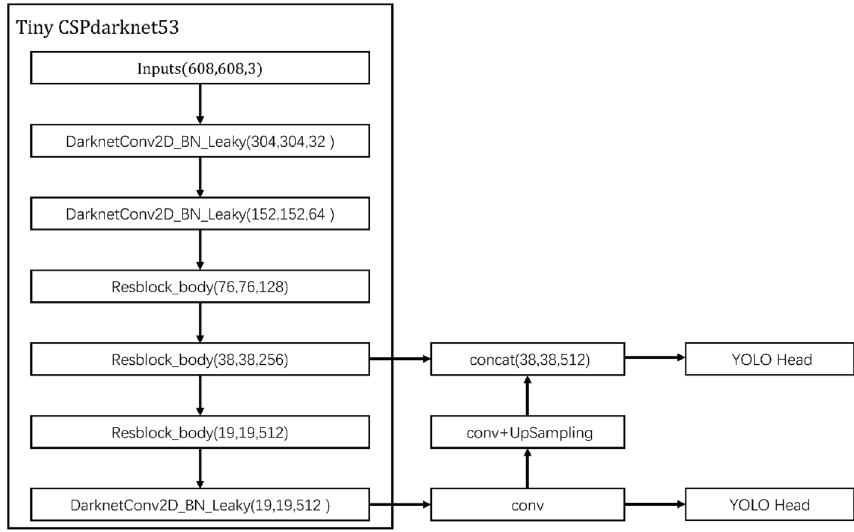
Figure 4. YOLOv4-tiny architecture.